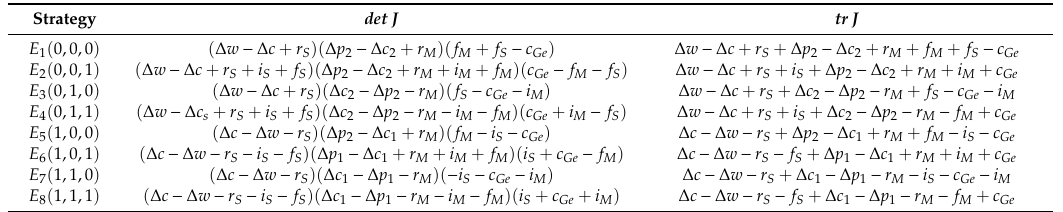
Table 4. The det J and tr J of eight